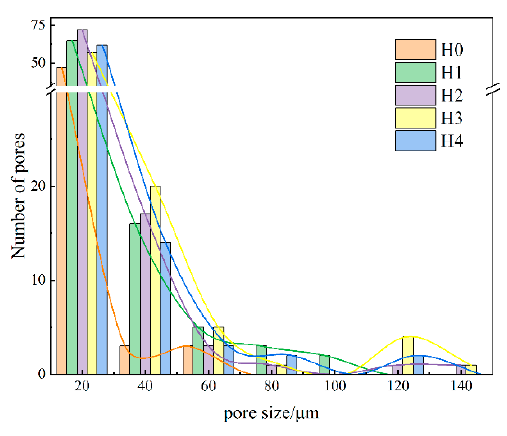
Figure 10. Deposited sample